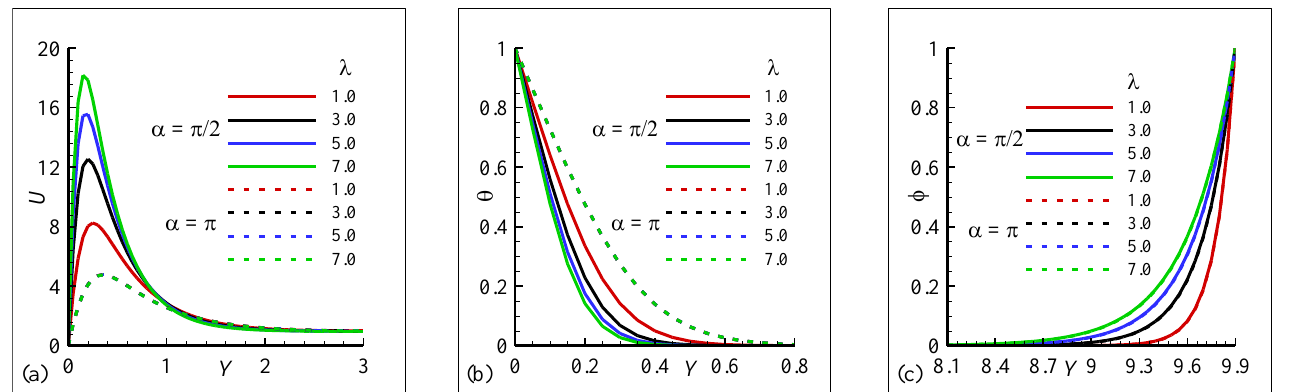
Figure 4. The geometrical representation of ( a ) 𝑈 , ( b ) 𝜃 and ( c ) 𝜙 at 𝜋 2⁄ and 𝜋 positions with four choice values of 𝜆 = 0.1,0.71,2.0 and 7.0 with some fixed parameters 𝛾 = 0.3 , 𝜉 = 0.9 , Pr = 7.0 , and Rg = 0.3 .